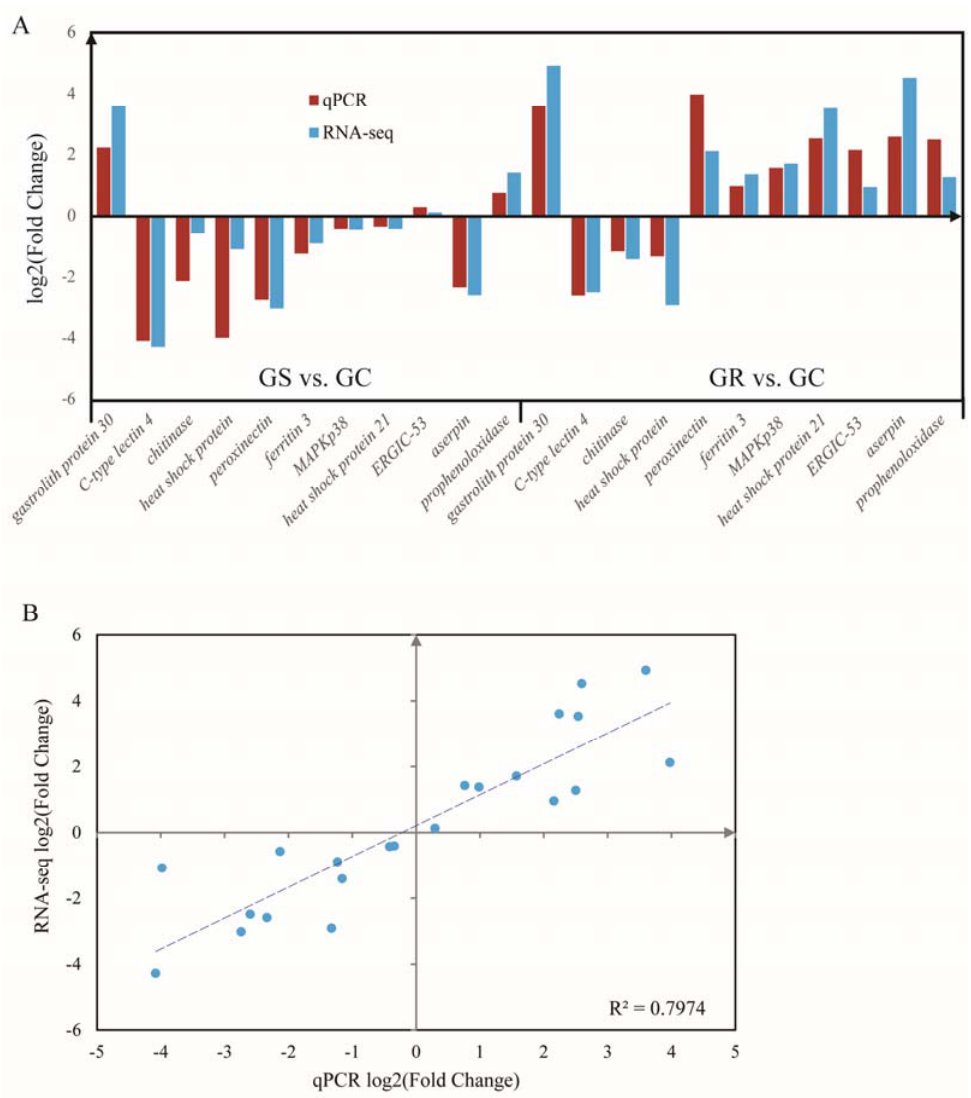
Figure 4. Quantitative real-time PCR (qRT-PCR) validation ( A ) and linear regression analysis ( B ) of RNA sequencing of selected DEGs.